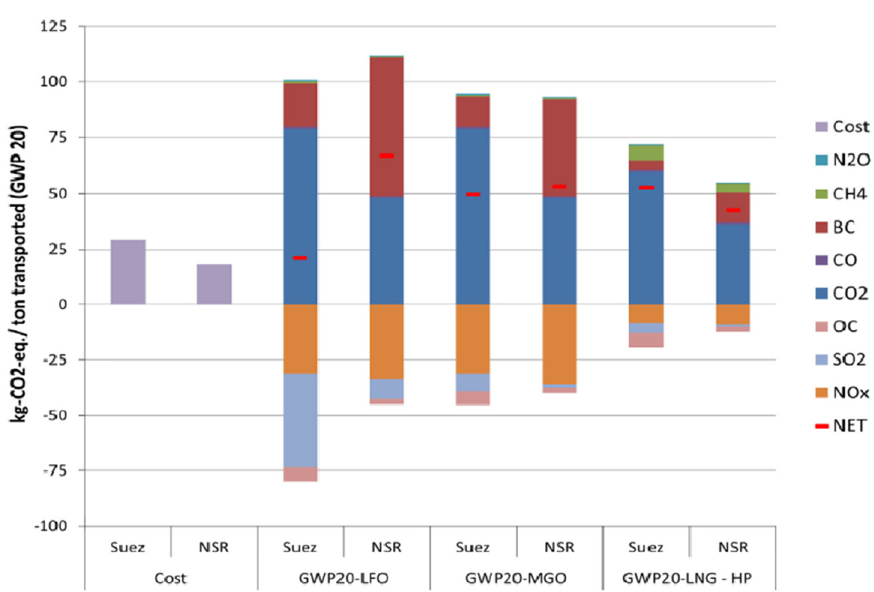
Figure 3: Suez versus NSR trades cost and kg CO 2 equivalent ( GWP 20 ) per ton transported per fuel type [ 27 ] .